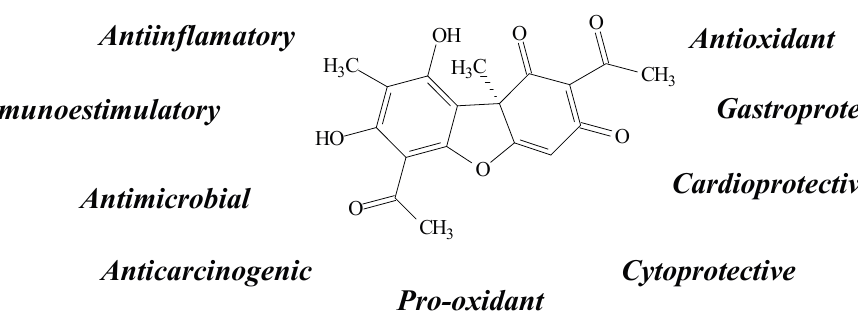
Figure 2. Usnic acid structure and biological